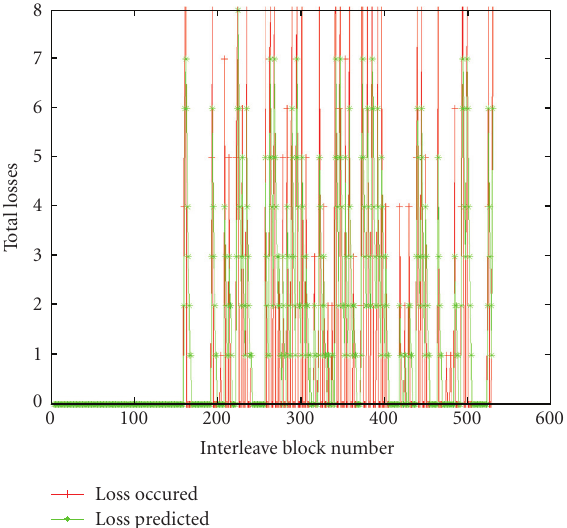
Figure 13: Performance of feedback for “ all ” sequence at 64 kbps, random delay 0.02, bu ff er size 250, packet size 256, span 16, PL rate 18.63%.